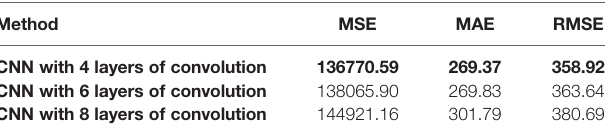
TABLE 9 | Survival prediction results of different CNN network